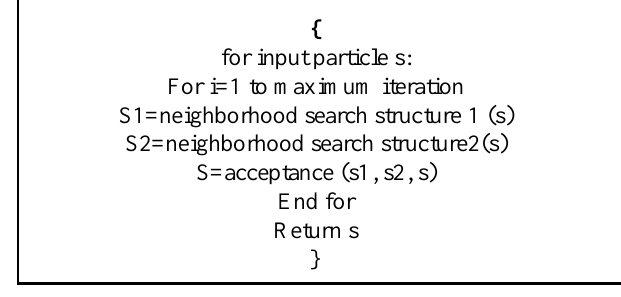
Figure 2. Improvement trend